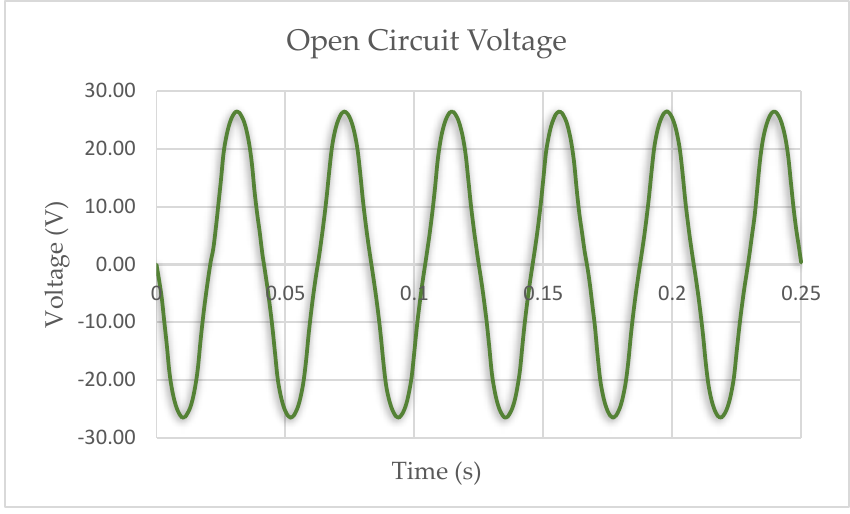
Figure 10. Open-circuit AC voltage. The simulation is done for a rotation speed of 360 RPM and observed sinusoidal emf distortion or ripple in the voltage due to